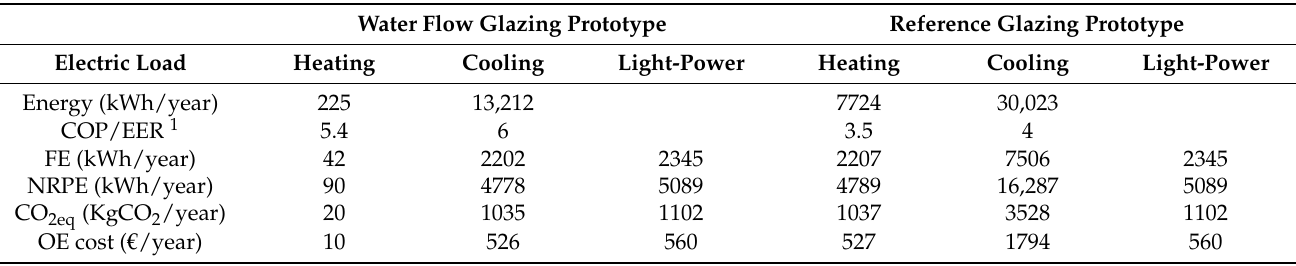
Table 6. Final energy, non-renewable primary energy, and CO 2 emissions per year.